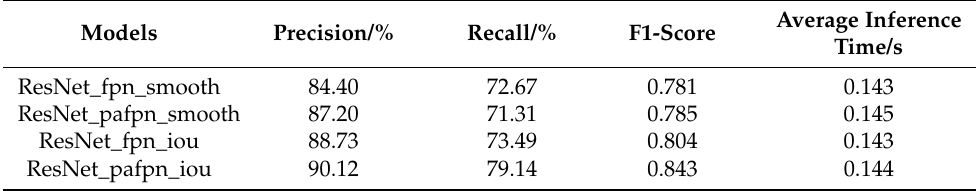
Figure Figure 6 shows the training loss curve of the ResNet_fpn_smooth, ResNet_pafpn_smooth, ResNet_fpn_iou, and ResNet_pafpn_iou. The training loss de- creased to a low value within a short time after the training started, then slowly reduced with the training process. The training loss became flat when the iteration was about